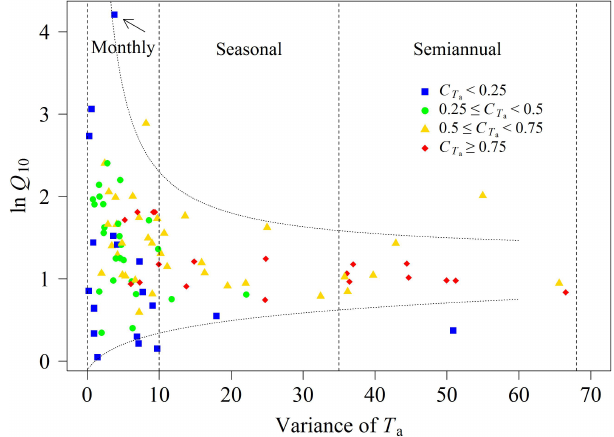
Fig. 5. Relationships between C Tide and s on different temporal scales. Monthly scale has much higher C Tide (relative importance of tides) than semiannual scale, while s (tidal effect parameter) is less than